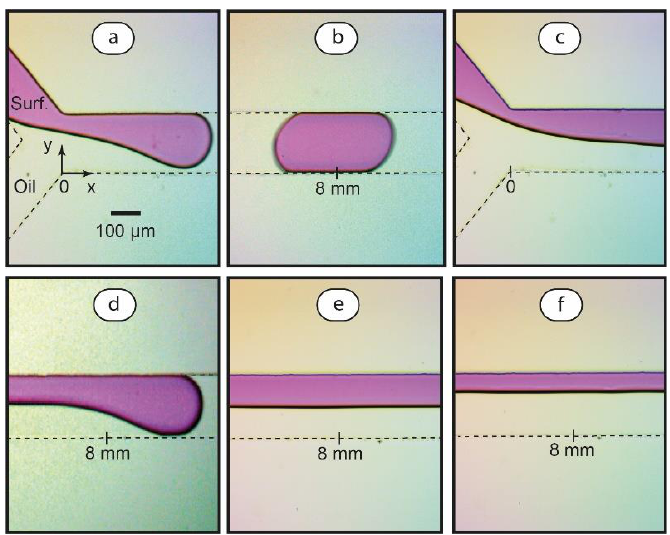
Figure 3. Optical microscopy images of aqueous SDS (1.2 × 10 −3 mol/L) and hexadecane flows: droplet formation ( a ) and break-up ( b ) at Ca ≈ 0.005 and φ = 0.1; thread generation ( c ) and break-up ( d ) at Ca ≈ 0.03 and φ = 1; stable threads at Ca ≈ 0.05, φ = 1 ( e ) and Ca ≈ 0.05, φ = 0.3 ( f ). Dye (phenolphthalein + 0.01 M KOH) was added to the surfactant solution for visualization. Dashed lines mark microchannel boundaries.